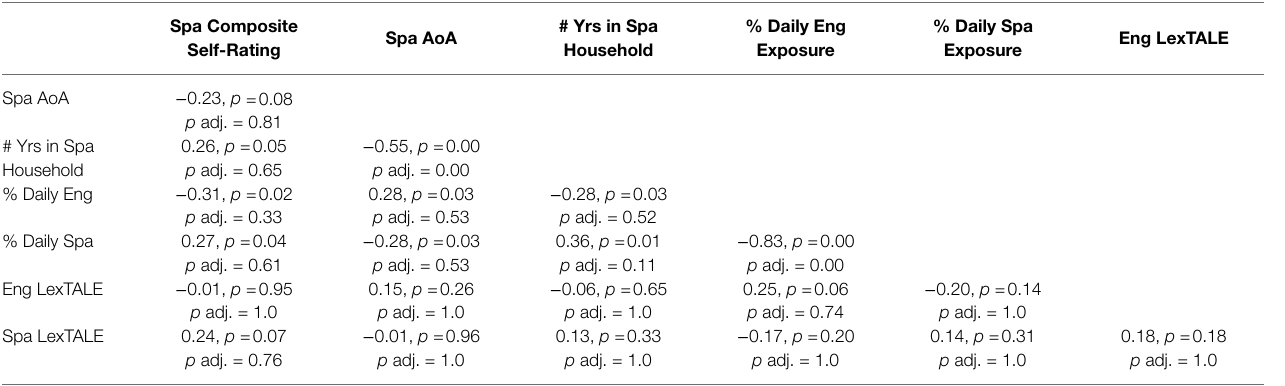
TABLE 5 | Correlation matrix (Kendall’s τ ) for individual difference